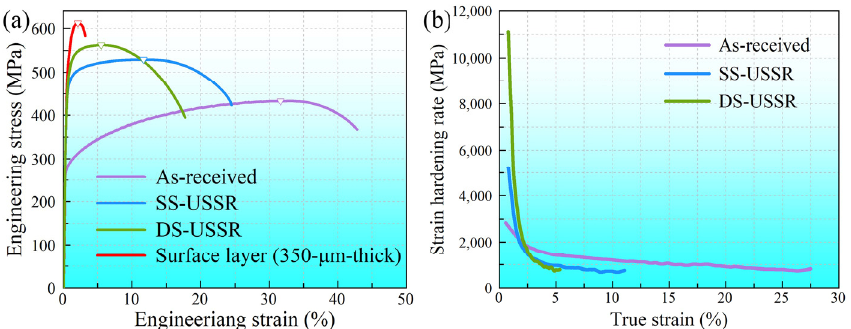
Figure 6. ( a ) Tensile stress–strain curves of the as-received, SS-USSR, DS-USSR samples as well as a 350- µ m-thick surface layer; ( b ) Strain hardening rate as a function of true strain of the as-received, SS-USSR, DS-USSR